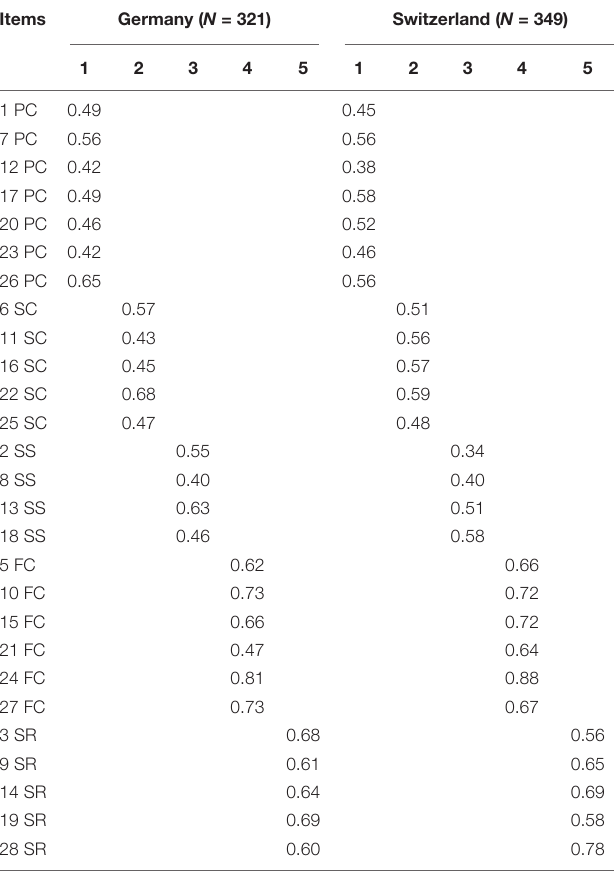
TABLE 3 | Standardized factor loadings in both